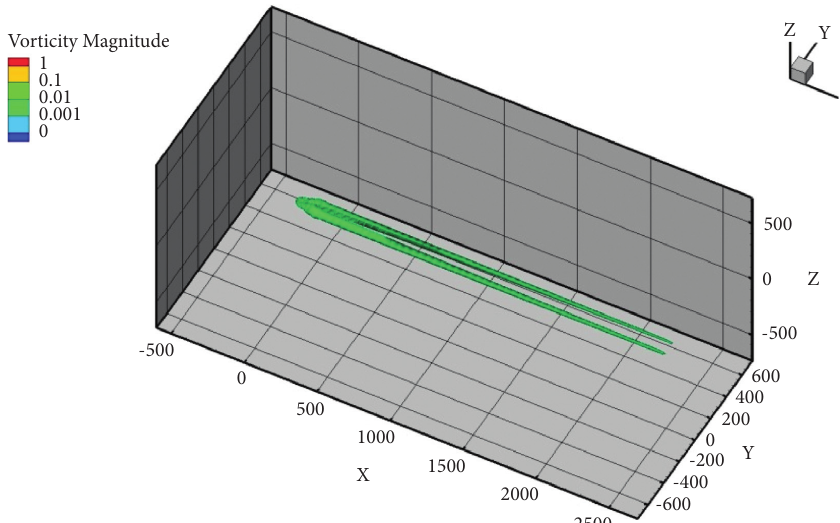
Figure 12: Isosurface map of the tail vortex of the paired aircraft with a vortex of 0.01 under static wind